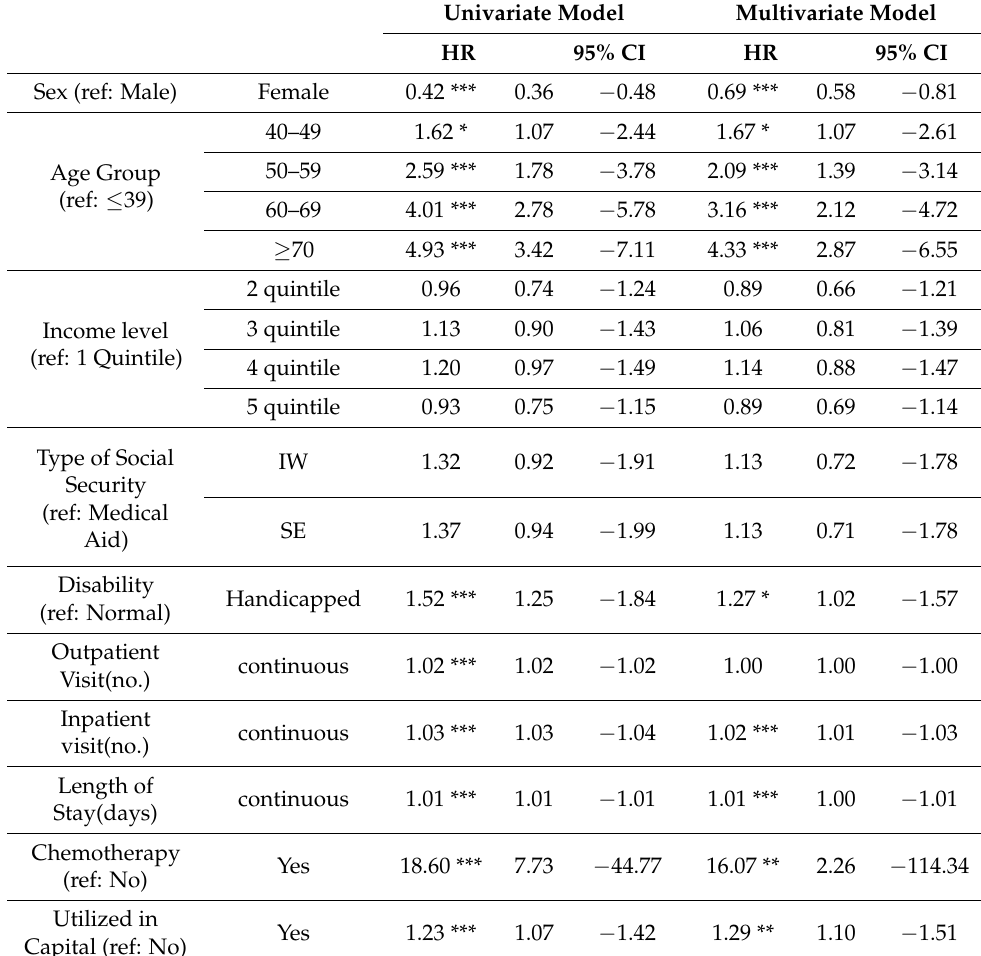
Table 4. Factors related to survival of cancer patients by a Cox proportional hazard model.